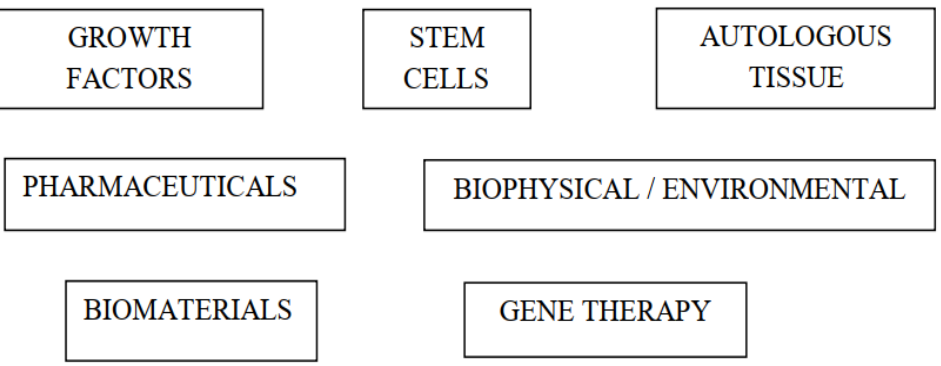
Figure 2. Biological augmentation methods used in anterior cruciate ligament reconstruction (ACLR).